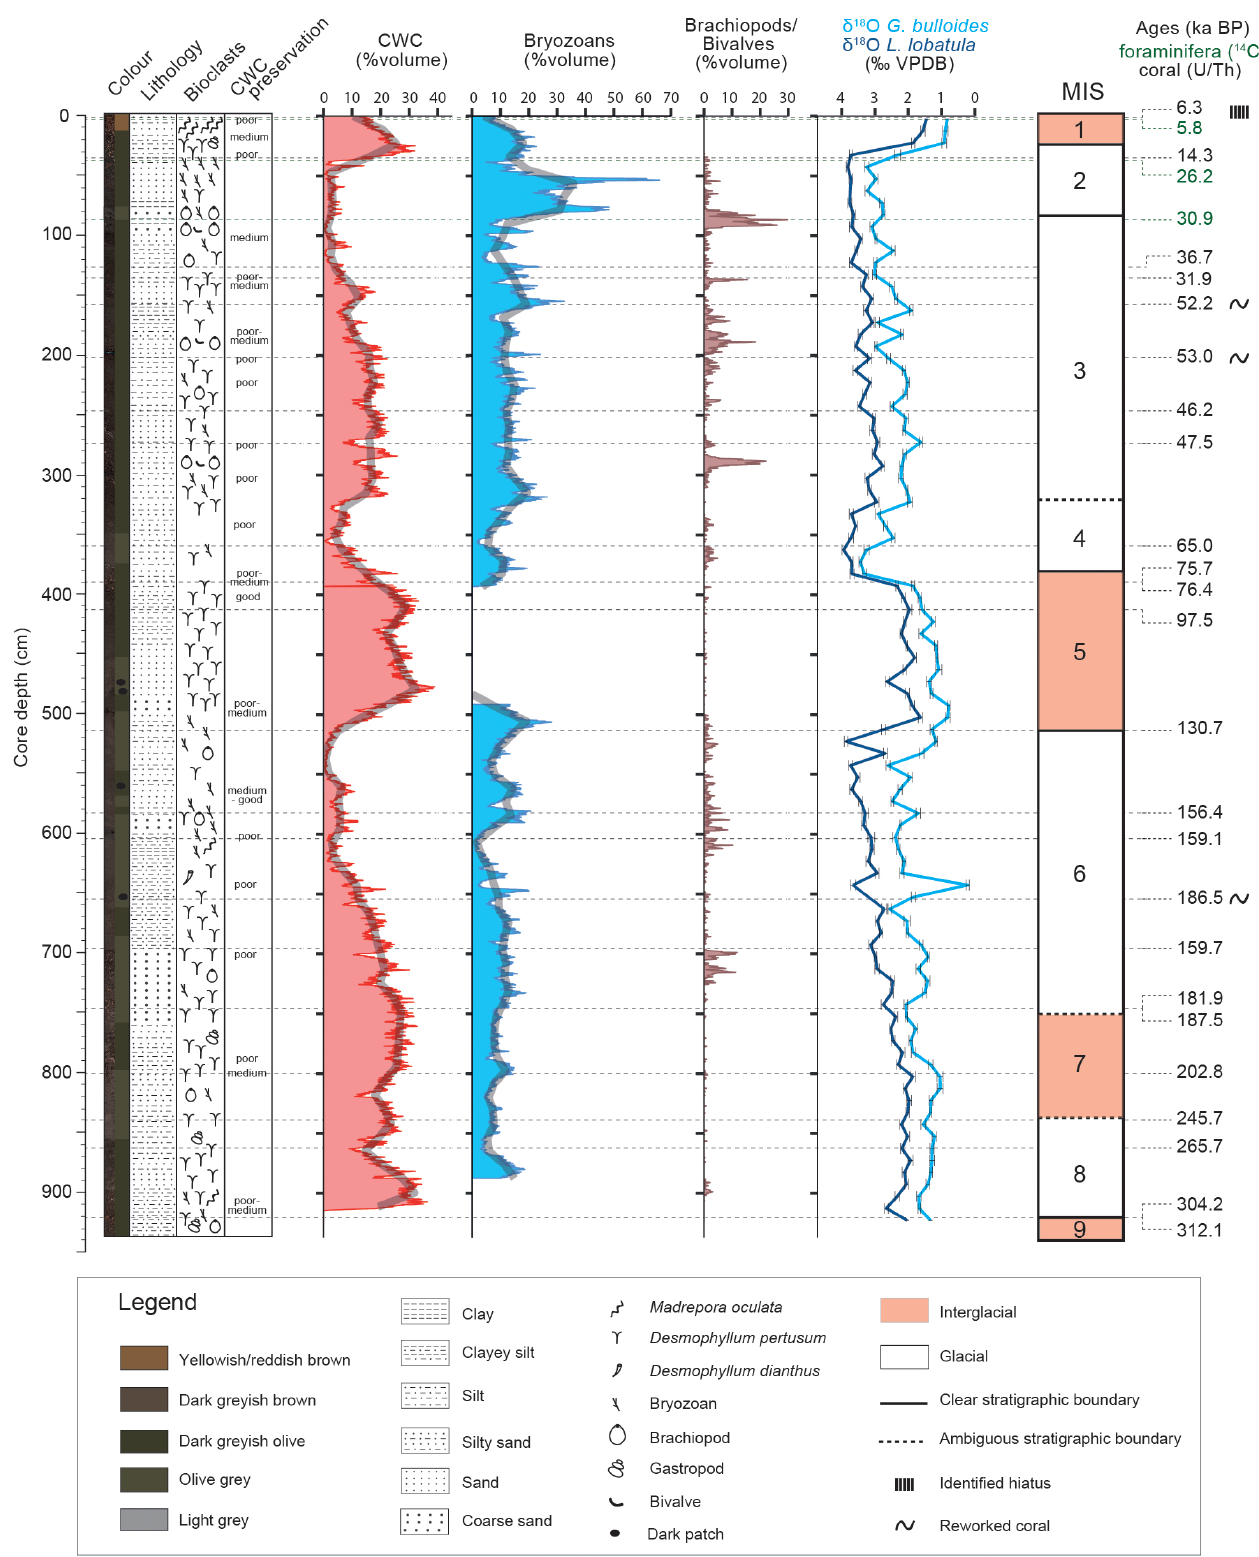
Figure 3. Core description, stratigraphy, and macrofaunal composition of core MD13-3462G. Stratigraphy is based on the planktonic ( G. bulloides ) and benthic ( L. lobatula ) δ 18 O records (‰VPDB), the uranium-series ages of coral fragments, and the epibenthic foraminiferal radiocarbon ages for the first metre of the core (see Fig.